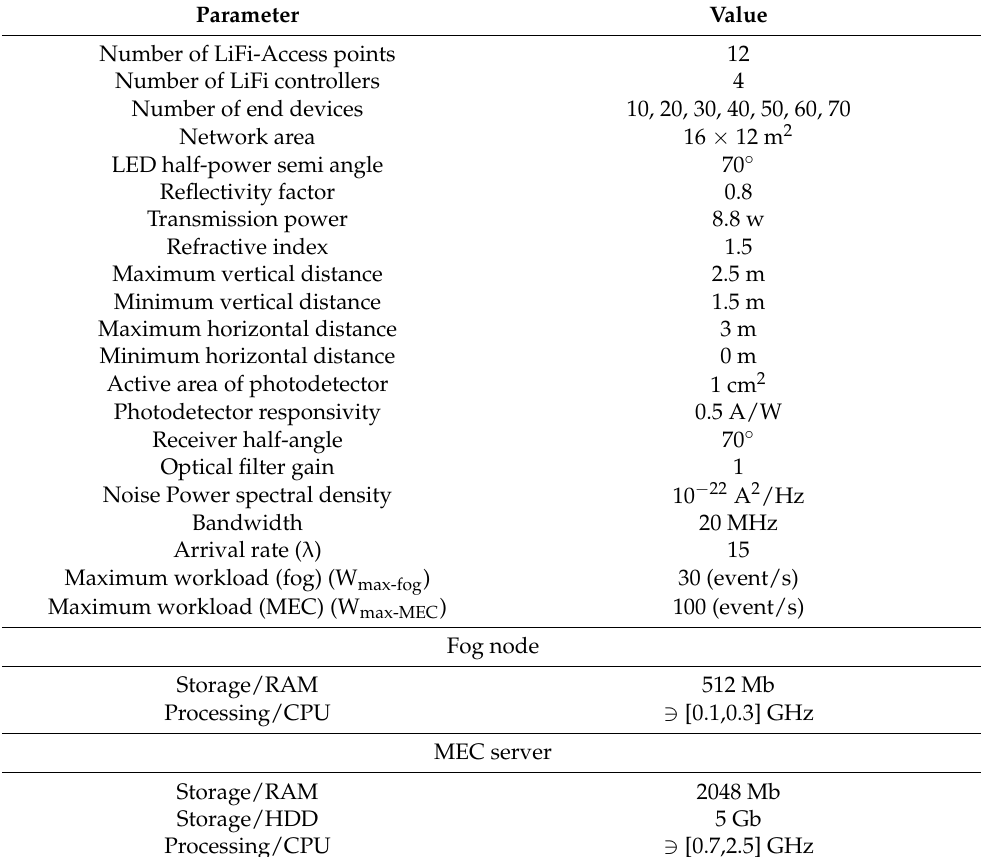
Table 1. Simulation